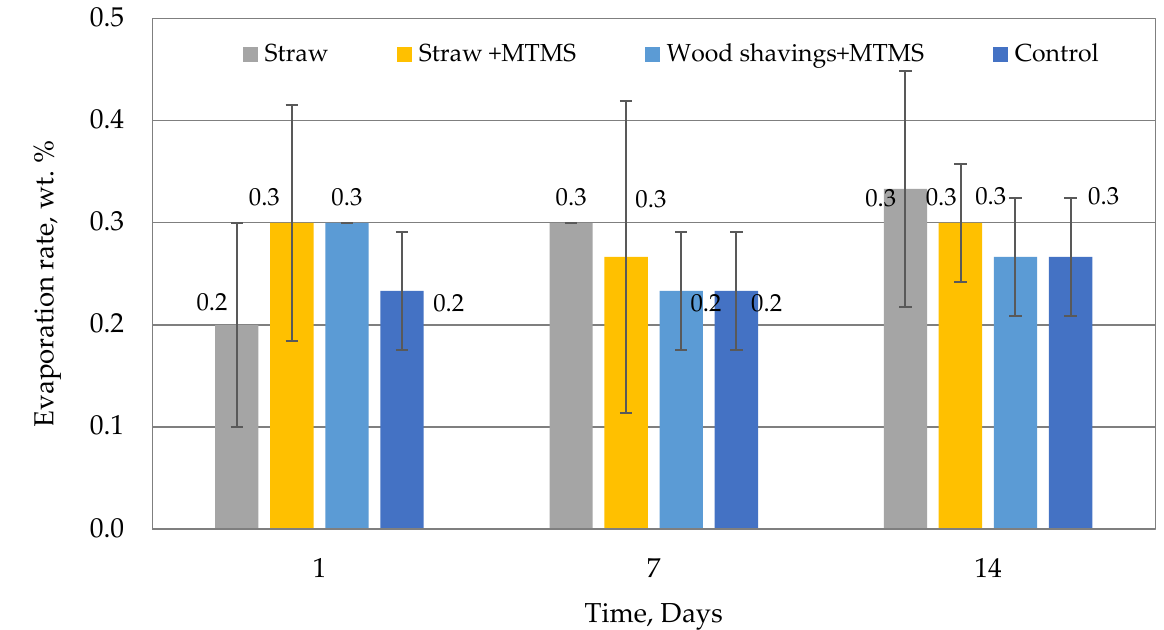
Figure 5. Evaporation rates of lubricating oil from the surface of the sorbents. Evaporation rate of lubricating oil on Baltic Sea water after 1, 7 and 14 days in the presence of straw with and without MTMS treatment and MTMS treated wood shavings compared with control samples.